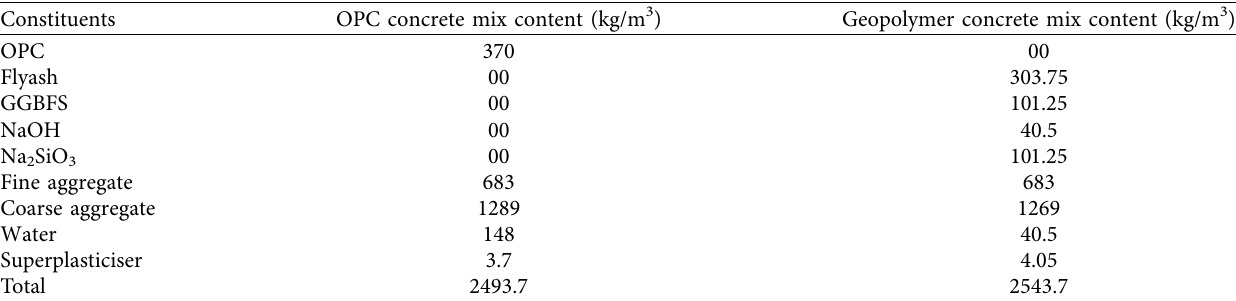
Table 2: Mix proportion of GPC and OPC